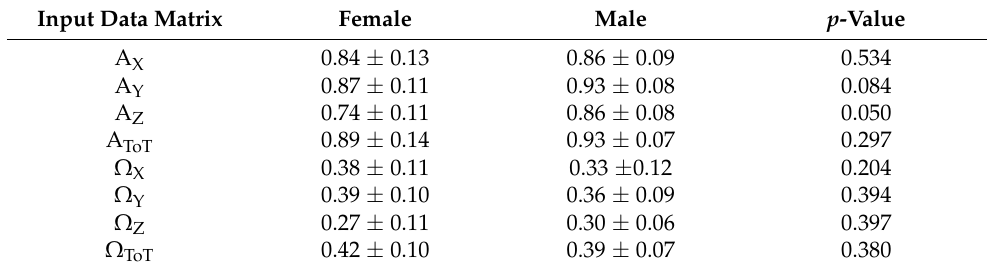
Table 4. Pearson correlation coefficient between best-matching retained PCs and V AB (mean ± standard deviation). The p -value is the outcome of the unpaired t -test comparing the effect of the factor gender on the independent variables. The p -values are highlighted in bold when reaching significance ( p <